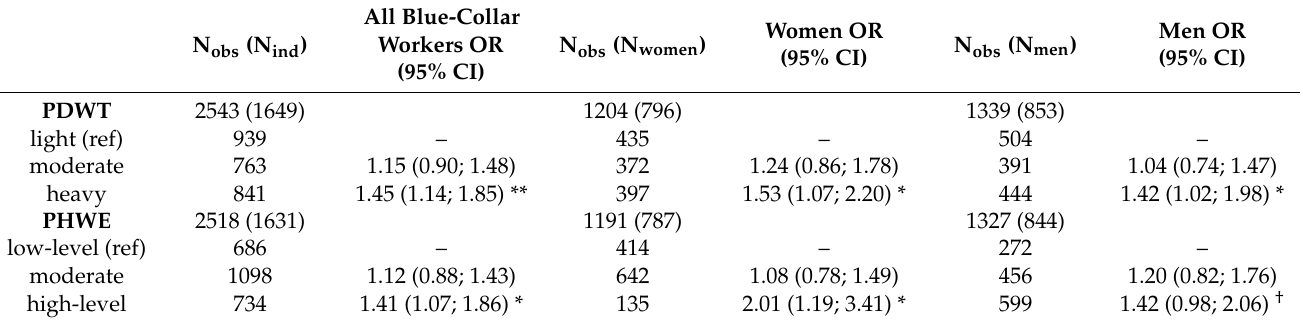
Table 1. Blue-collar workers. Odds ratio (OR) and 95% confidence interval (CI) of retired (1) vs. still in work (0) two years later in relation to PDWT and PHWE in trichotomised variables. Separate